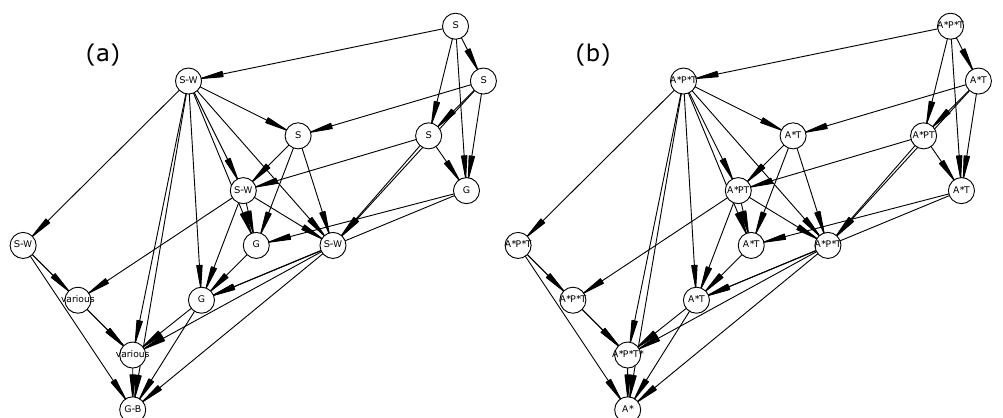
Figure 3. Hierarchical Transition Graph (HTG) of the “dry period” scenario. The same HTG is represented with a focus on either vegetation ( a ) and socio-economic ( b ) dynamics. Graph nodes are SCCs and each transition is, by definition, irreversible. Therefore, dynamics within each node display some form of oscillation. Letters correspond to vegetation types (B: Bare soil; G: Grassland; S: Savanna; W: Woodland) or socio-economic activities (A: Agriculture; P: Pastoralism; T: